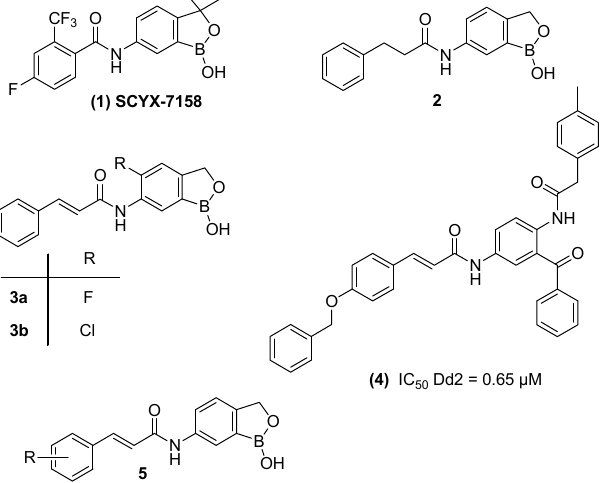
Figure 2. Chemical structures of antifungal, antiplasmodial, and trypanocidal benzoxaboroles including the proposed cinnamoyl-oxaborole amides ( 5 ).